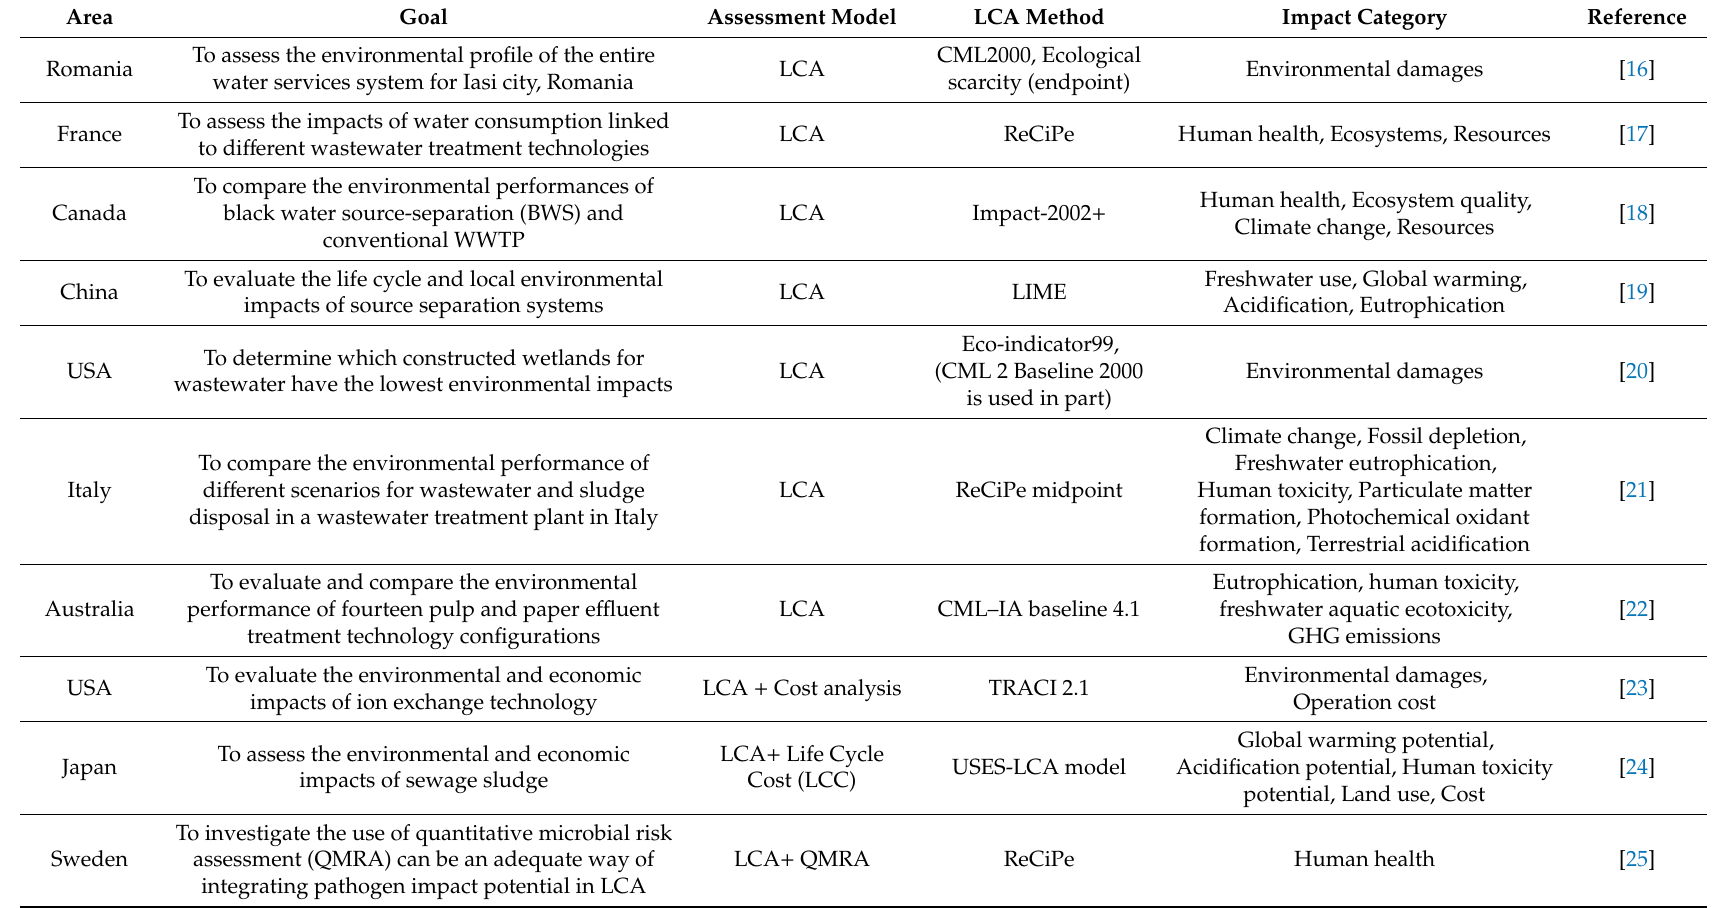
Table 1. Recent life-cycle assessment (LCA) studies in waste water treatment plants (WWTPs).